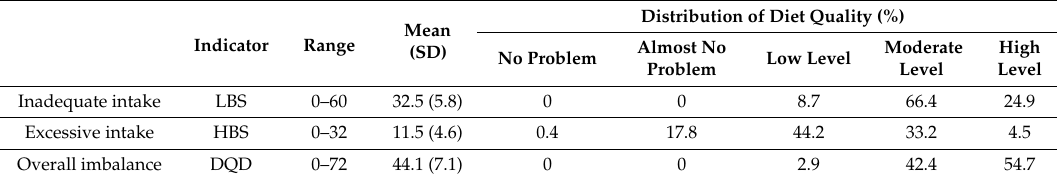
Table 2. Distribution of DBI-07 indicators among the